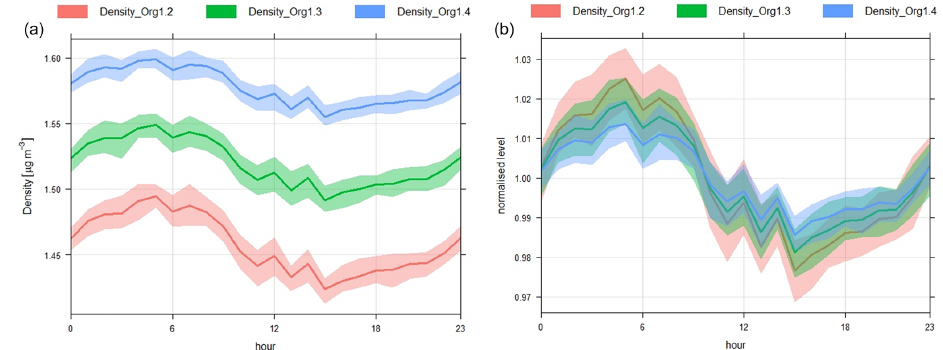
Figure A11. Diurnal trends of average ρ m calculated based on Eq. (2) in winter for different organic densities (1.2, 1.3, and 1.4gcm − 3 ) in absolute (left) and normalized (right) values.